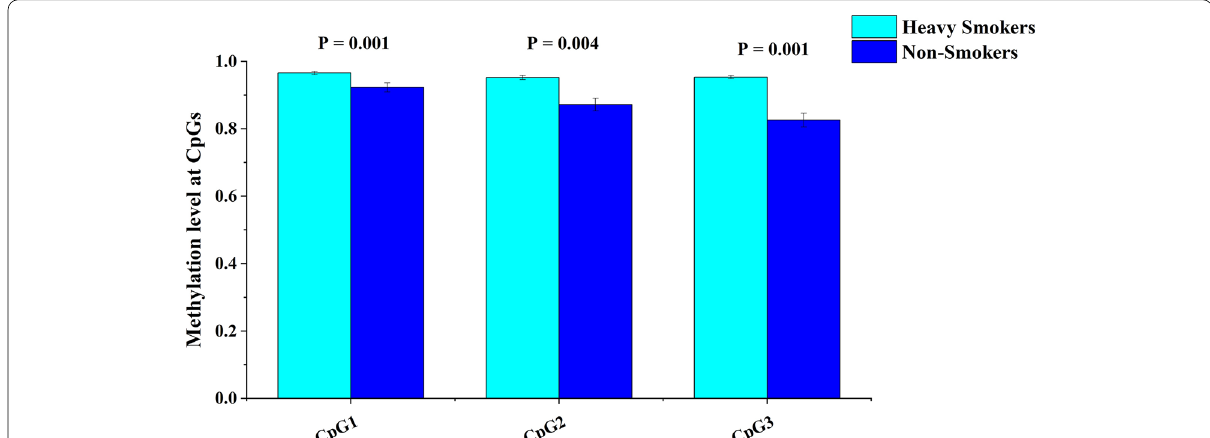
Fig. 6 Methylation level at CpGs within PRRC2A gene-related amplicon in heavy smokers compared to non-smokers. P < 0.05: significant; P not significant